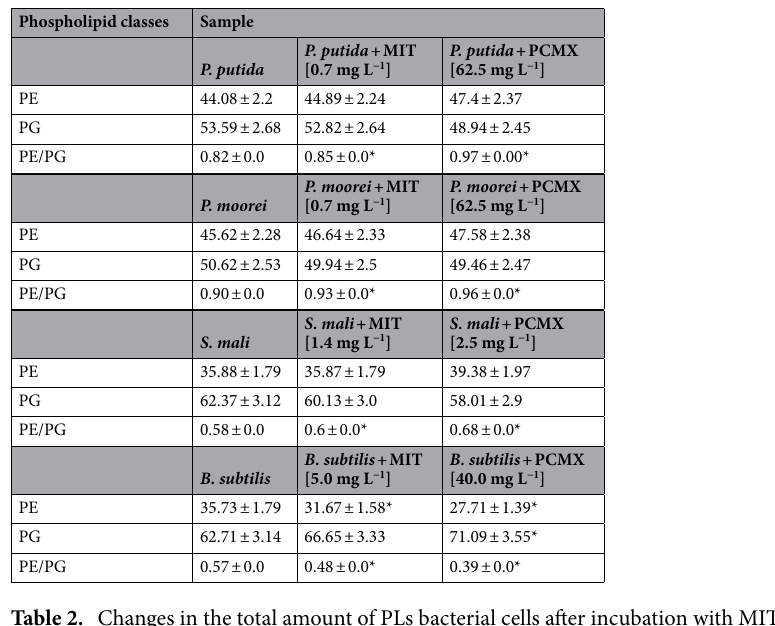
Table 2. Changes in the total amount of PLs bacterial cells after incubation with MIT or PCMX. Data are expressed as the average percentage ± SD (n = 3). The presented results were analysed using the Mann–Whitney U test with *p <